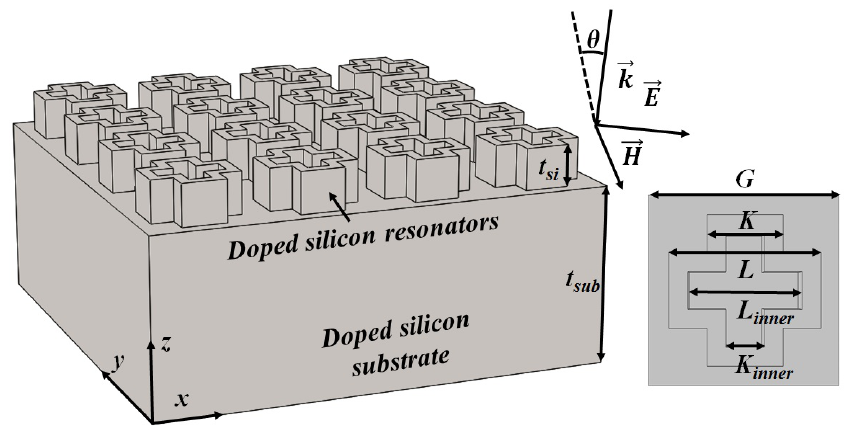
Figure 1. Schematic drawing of the proposed THz absorber.